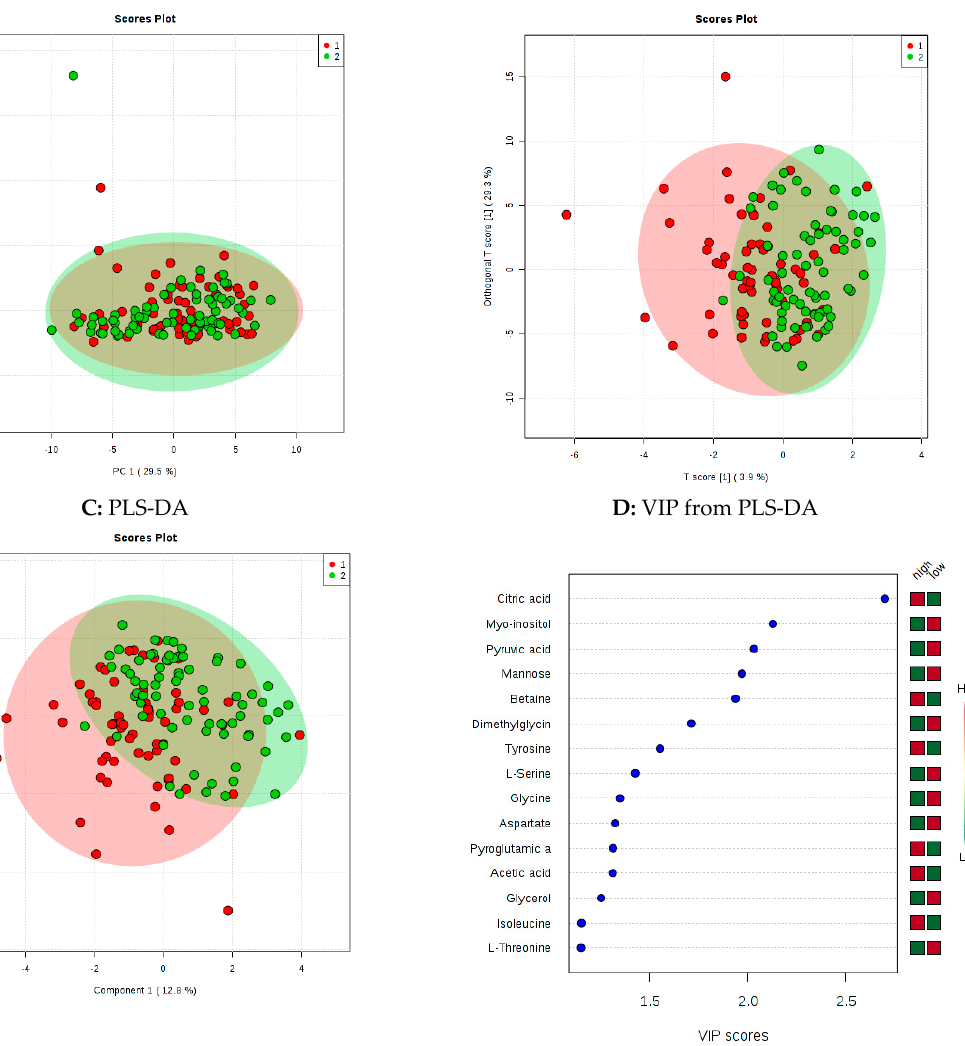
Figure 1. Multivariate statistical modelling of 1 H-Nuclear Magnetic Resonance 1 H-NMR metabolomic data. Plots A–C show group separation achieved by principal component analysis (PCA), orthogonal partial least squares discriminant analysis (OPLS-DA) and partial least squares discriminant analysis (PLS-DA). Red circles ( (cid:8) 1) represent patients with high MDS and green circles ( (cid:8) 2) represent individuals with low MDS. D: Is the resulting variable importance in project (VIP) plot indicating the 15 most influential metabolites responsible for the observed separation in the PLS-DA